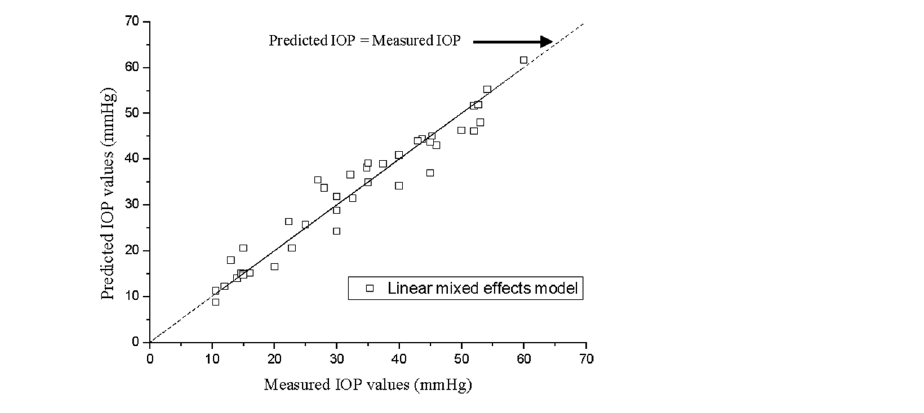
Figure 5. The measured IOP values against the predicted IOP values by LMM. Statistical analysis result was created by the authors using MATLAB R2019b (https ://kr.mathw orks.com/produ cts/new_produ cts/relea se201